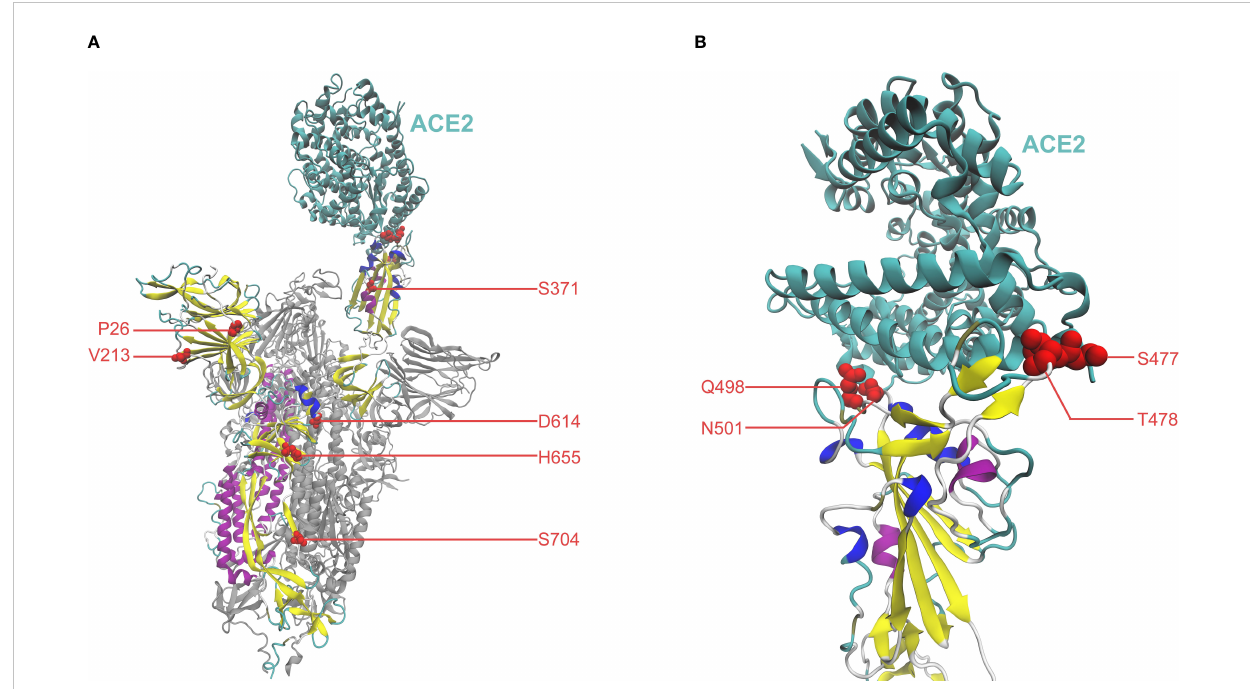
FIGURE 2 (A) Residues of the top ten mutations represented by red spheres, in the Spike-ACE2 complex (PDB: 7A94) (Benton et al., 2020; Wrobel et al., 2020), visualized by Visual Molecular Dynamics (VMD) (Humphrey et al., 1996; Stone et al., 2013). ACE2 is colored in cyan. The Spike monomer binding with ACE2 is colored, with the other monomers in grey. (B) Close-up view of the binding interface between Spike and